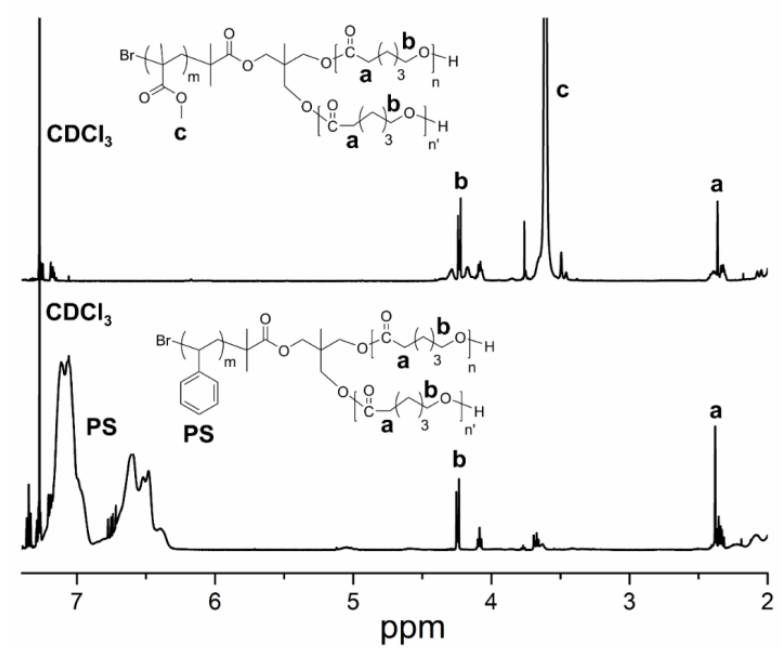
Figure 1. 1 H NMR spectra of PMMA-(PCL) 2 and PS-(PCL) 2 .